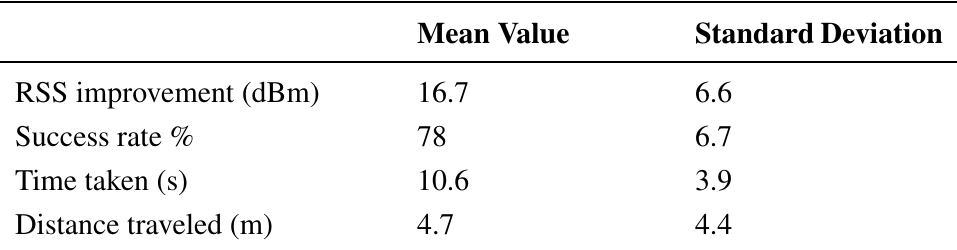
Table 2. Summarized results of the field